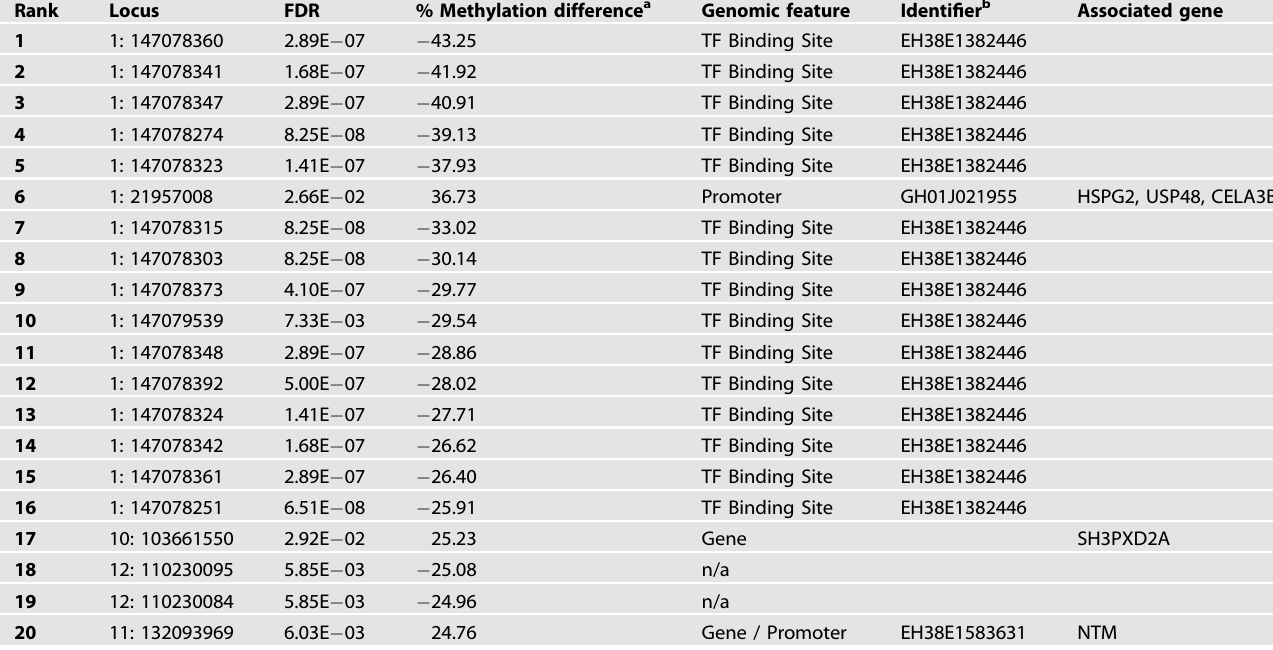
Table 2. List of Top 20 differentially methylated CpG